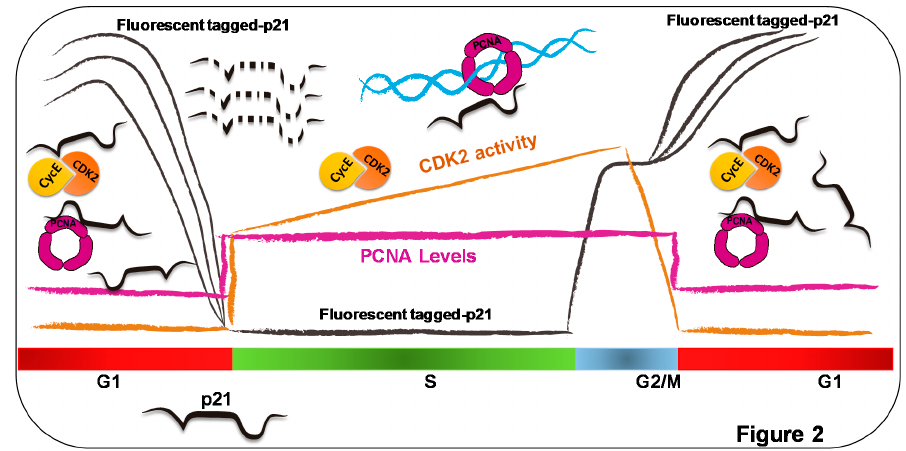
Figure 2. Cell cycle imposes strong regulation on p21 levels in S phase. Levels of fluorescence-tagged p21, PCNA, and CDK activities presented by black, purple, and orange lines, respectively. Endogenous p21 levels not shown, as live image experiments focused on fluorescence-tagged p21. Only in G1 and G2 did p21 levels rise to an extent that could inhibit cyclin–kinase complexes such as CycE / CDK2. Since p21 levels in G1 are very heterogeneous, multiple black lines represent such dispersion in p21 expression. Length of the G1 phase correlates with p21 levels, which were higher than p21 levels in Phase G2 [16]. Whether p21 controls PCNA functions in G1 is still debated, but p21 overexpression levels, which are similar to highest levels reached by endogenous p21 after DNA damage, are not sufficient to modulate replicative DNA synthesis or nucleotide excision repair in G1 [51]. In S phase, levels of fluorescence-tagged p21 were undetectable both in unperturbed conditions and after γ -irradiation, nutlin-3, or neocarzinostatin (NCS) treatment, which are all well-characterized inducers of p21 [16,67,68]. These results indicate that excess of exogenous p21 is strongly prevented in the S phase. Either Cdt2 downregulation or the disruption of the PIP box of p21 allowed p21 upregulation in the S phase, indicating CRL4 Cdt2 that degrades PCNA-bound p21, tightly controlling p21 levels in the S phase [16,67]. p21 represented as black linear and unstructured peptide; dotted p21 represent p21